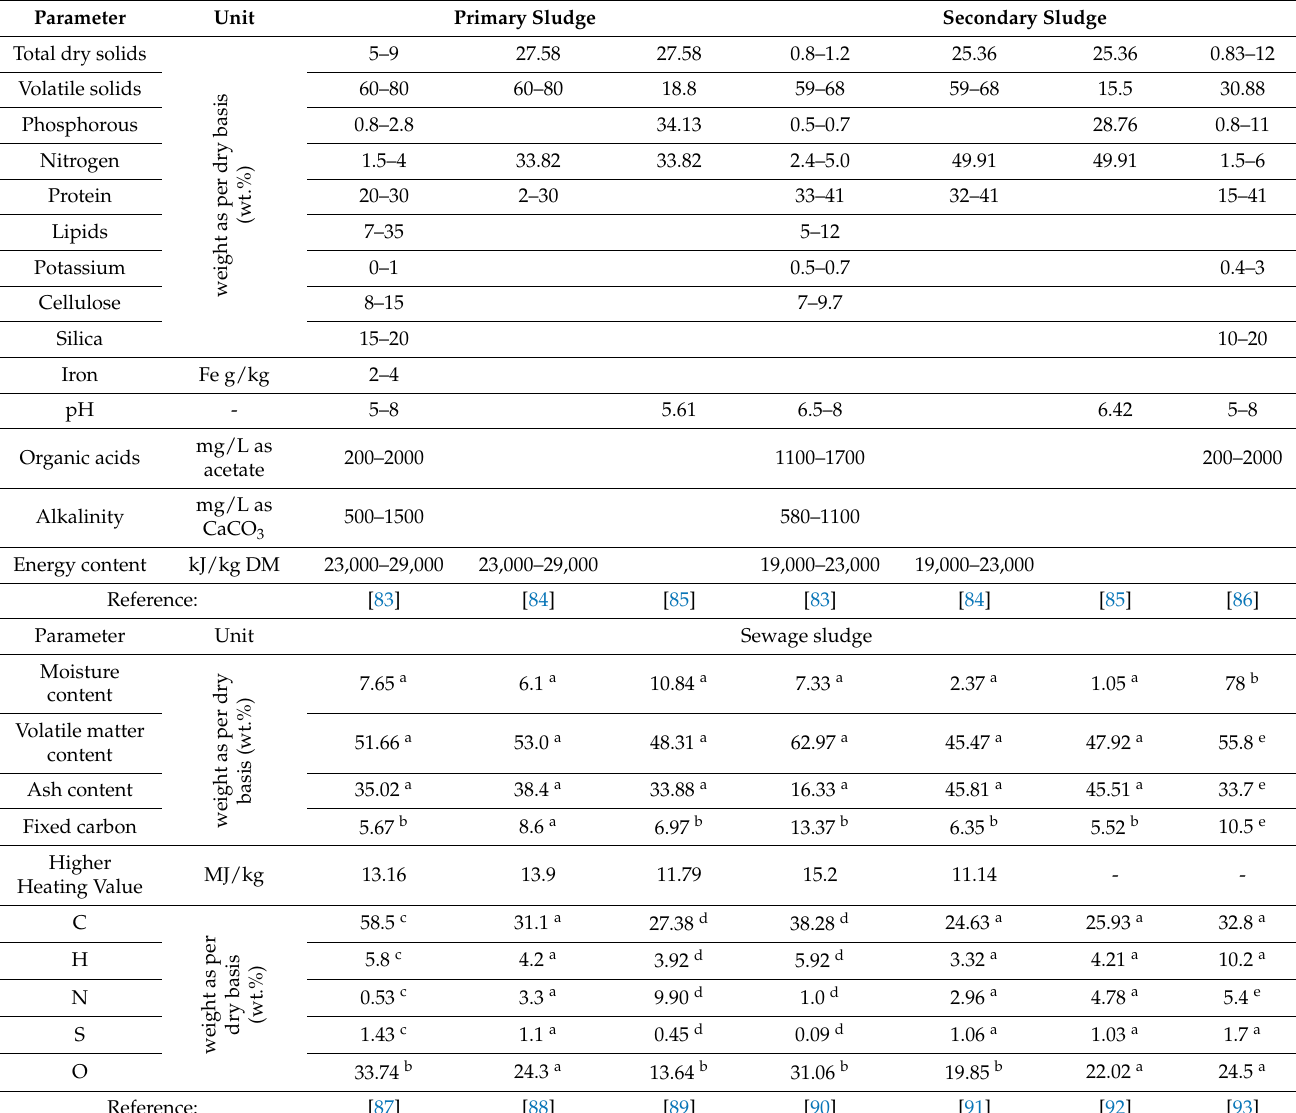
Table 1. Characteristics and composition of sewage